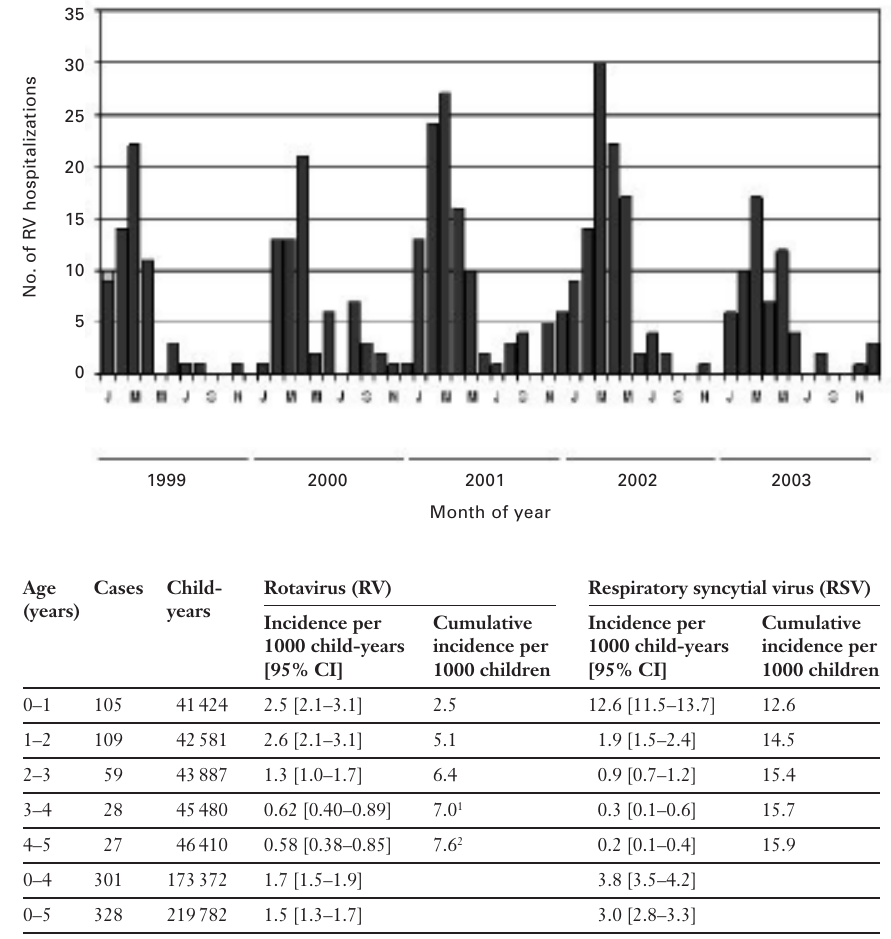
Age-specific commu- nity-acquired ro- tavirus (RV) and res- piratory syncytial virus (RSV) hospitali- sation incidences in the area of Bern,